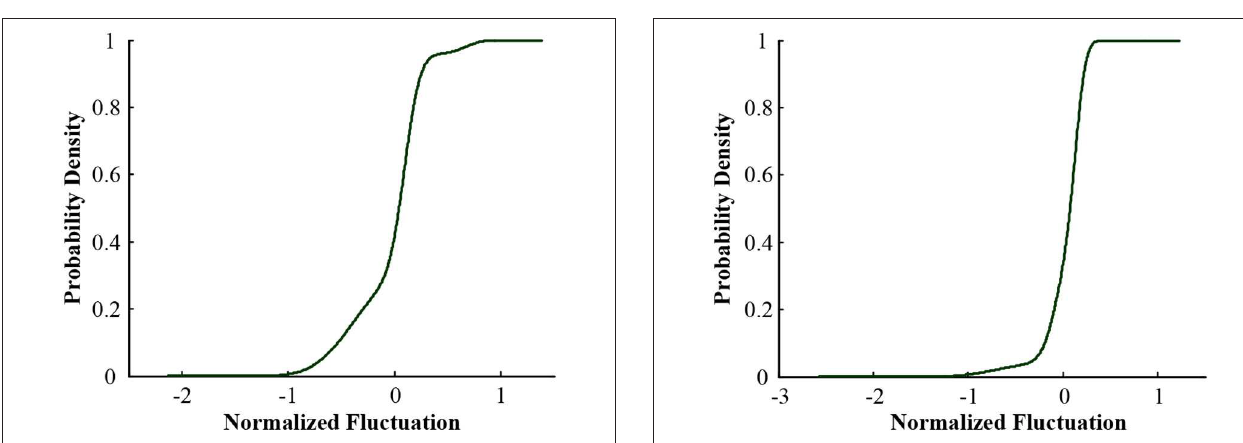
FIGURE 2 | Cumulative probability distribution of random components of PV output in Xichang City on July 20, 2018.